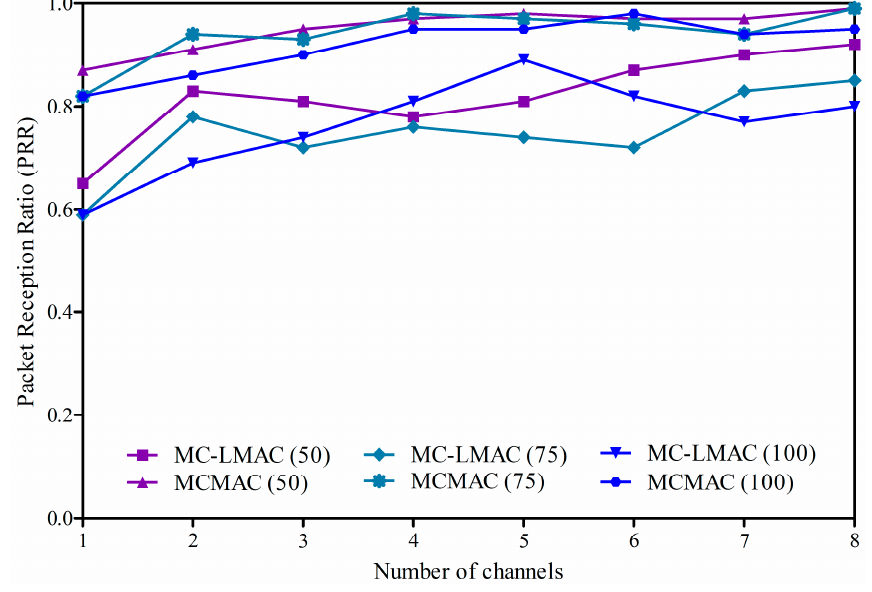
Figure 10. Packet reception ratio according to the number of channels and network density.